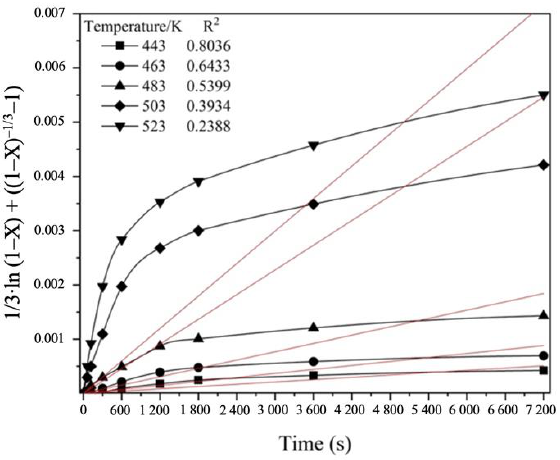
Figure 13. Linear relationship between 1/3 · ln (1 − X) + ((1 − X) − 1/3 − 1) and hydrothermal treatment time at various temperatures.